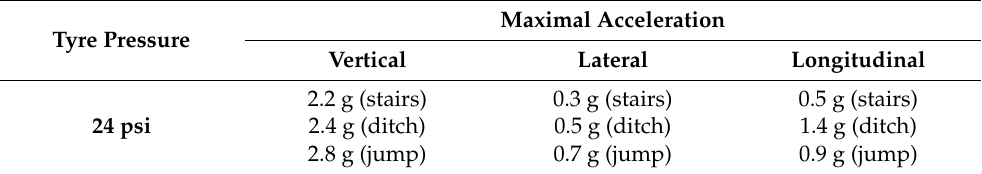
Table 1. Maximal acceleration in each direction and obstacle type.